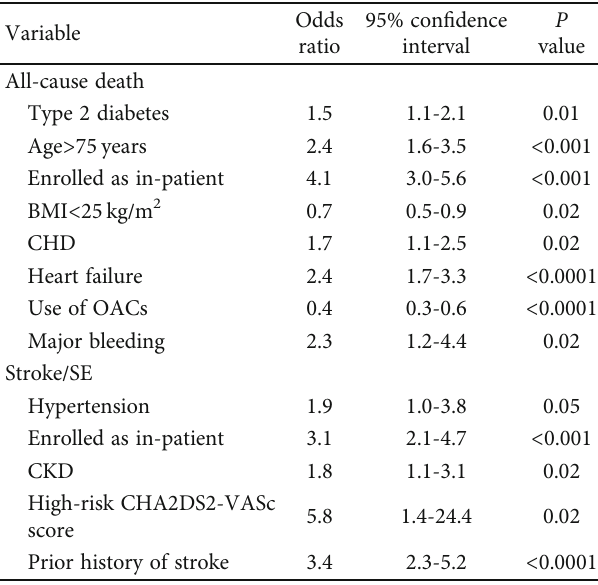
Table 4: Multivariate analysis of factors associated with all-cause death and stroke/SE among patients with nonvalvular atrial fi